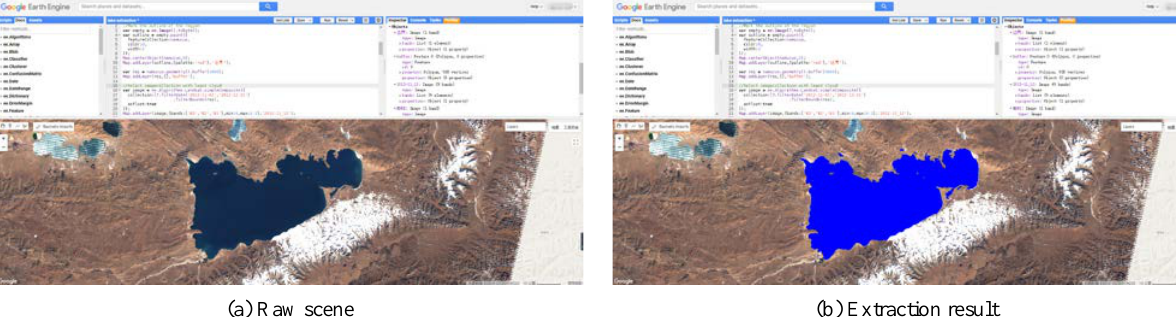
Figure 5. Extraction of Nam Co with Landsat7 gap-filled